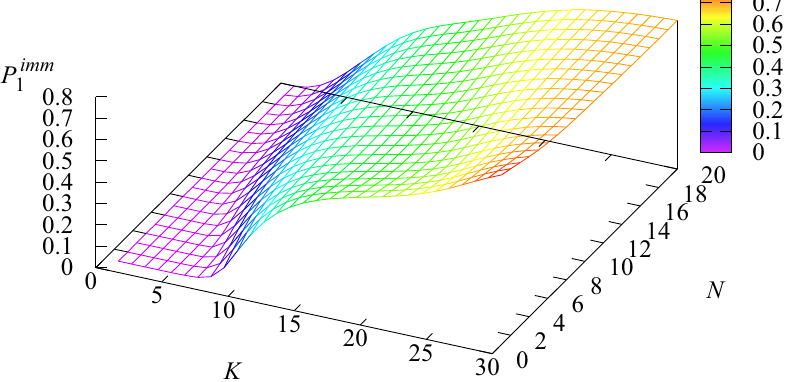
Figure 8. Dependence of the probability P imm System 1 upon arrival on the parameters N and K .